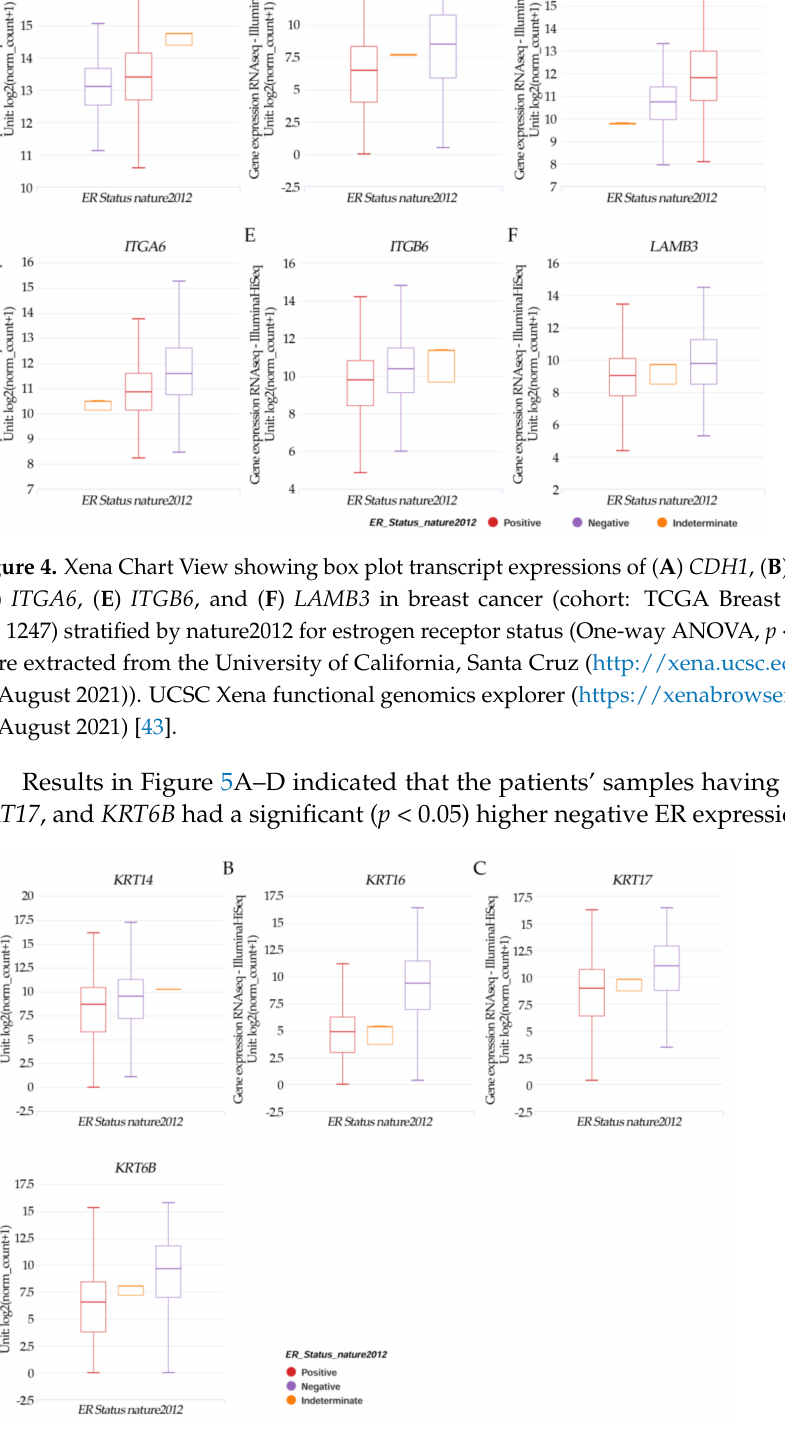
Figure 5. Xena Chart View showing a box plot transcript expression of the keratin genes ( A ) KRT14 , ( B ) KRT16 , ( C ) KRT17 , and ( D ) KRT6B in breast cancer (cohort: TCGA Breast Cancer (BRCA), n = 1247) stratified by nature2012 for estrogen receptor status (One-way ANOVA, p < 0.05). Raw data were extracted from the University of California, Santa Cruz (http://xena.ucsc.edu/ (accesses on 20 August 2021)). UCSC Xena functional genomics explorer (https://xenabrowser.net accessed on 20 August 2022)